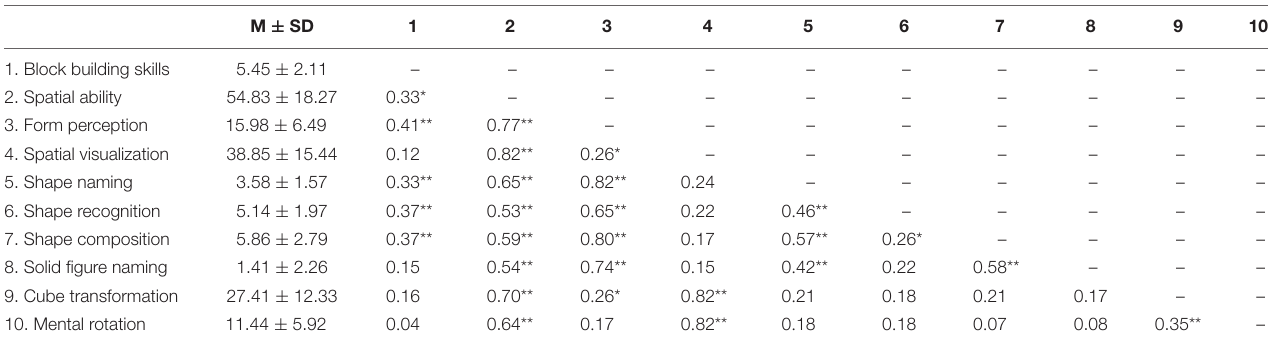
TABLE 1 | Correlations among key study